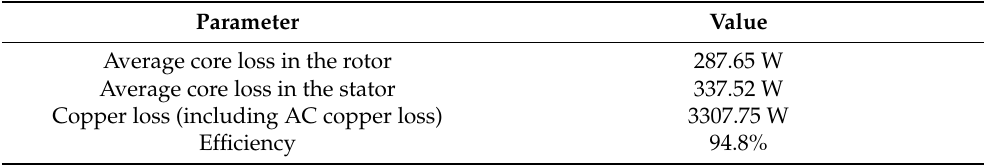
Table 7. Calculated Losses and Efficiency for Nominal Current Reference and Conduction Angles of − 47.9 ◦ To 125 ◦ .